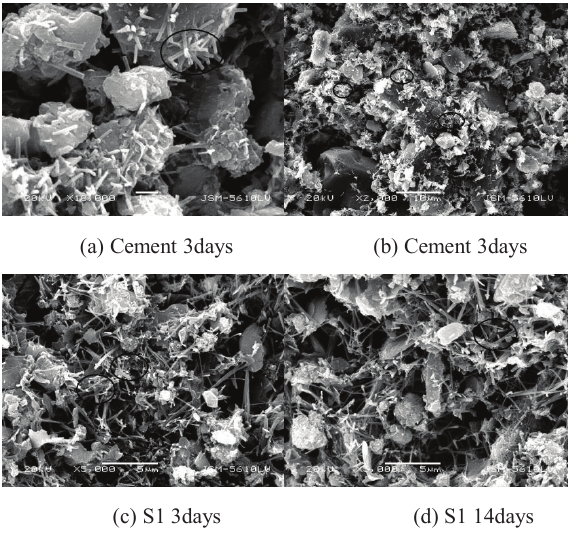
Figure 8: SEM analysis of hydration products in solidified sludge (a-b: SEM of cement solidified sludge curing at 3days; c-d: SEM of S1 solidified sludge curing at 3 days). The needle-like structure mineral formed a uniform cross sludge organism similar as ettringite, which is a major hydration by-product of tricalcium aluminate in the presence of sulfate ions as formulated by Equation (1). The ettringite/Fe – ettringite morphology closely